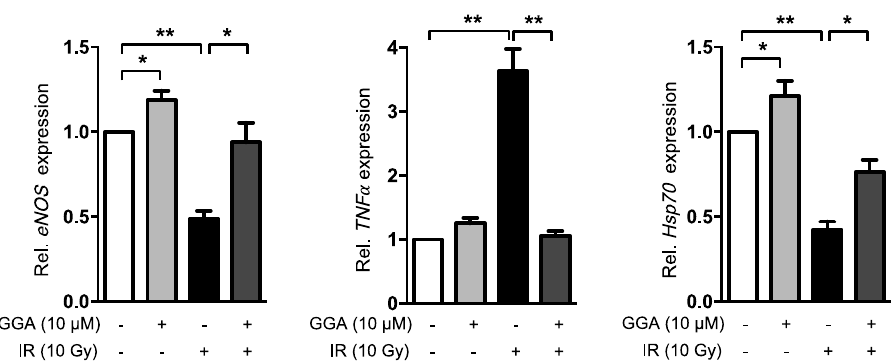
Figure 7. Activation of angiogenic signaling and suppression of inflammatory cytokine expression by GGA. HUVECs were treated with GGA for 3 h and subsequently irradiated and incubated for another 12 h. Restoration of VEGF, VEGFR1, VEGFR2, eNOS, and TNF α mRNA expression was detected by RT-qPCR analysis. Data are presented as the mean ± SEM; n = 6, * p < 0.05 and ** p < 0.01.